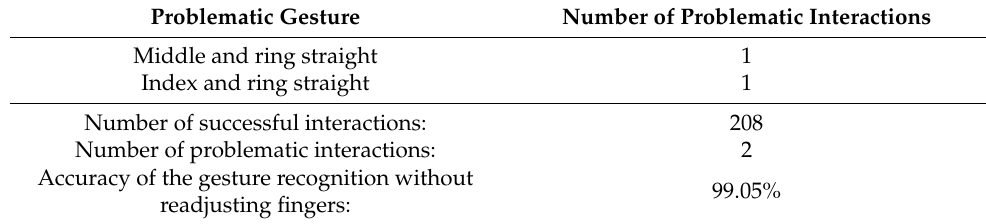
Table 3. Results of gesture recognition accuracy